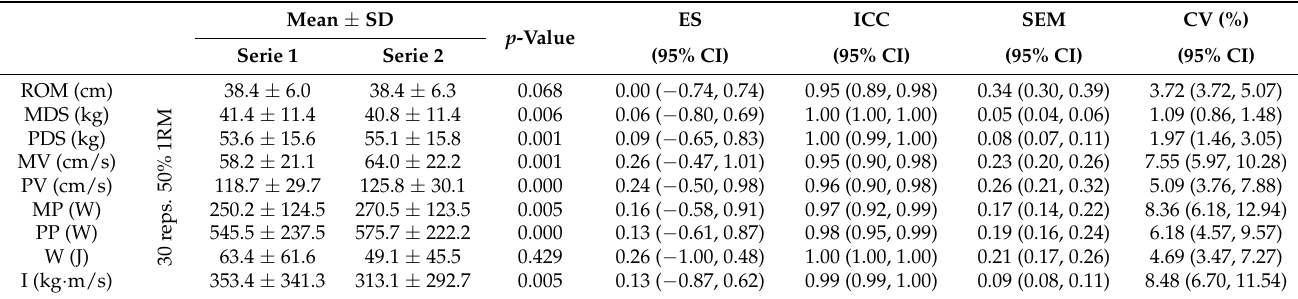
Table 1. Test–retest reliability of all variables during the 50% 1RM protocol using a FEMD.